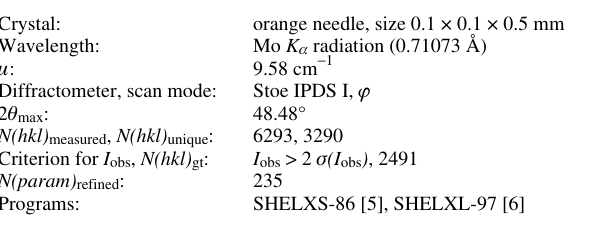
Table 1. Data collection and handling.